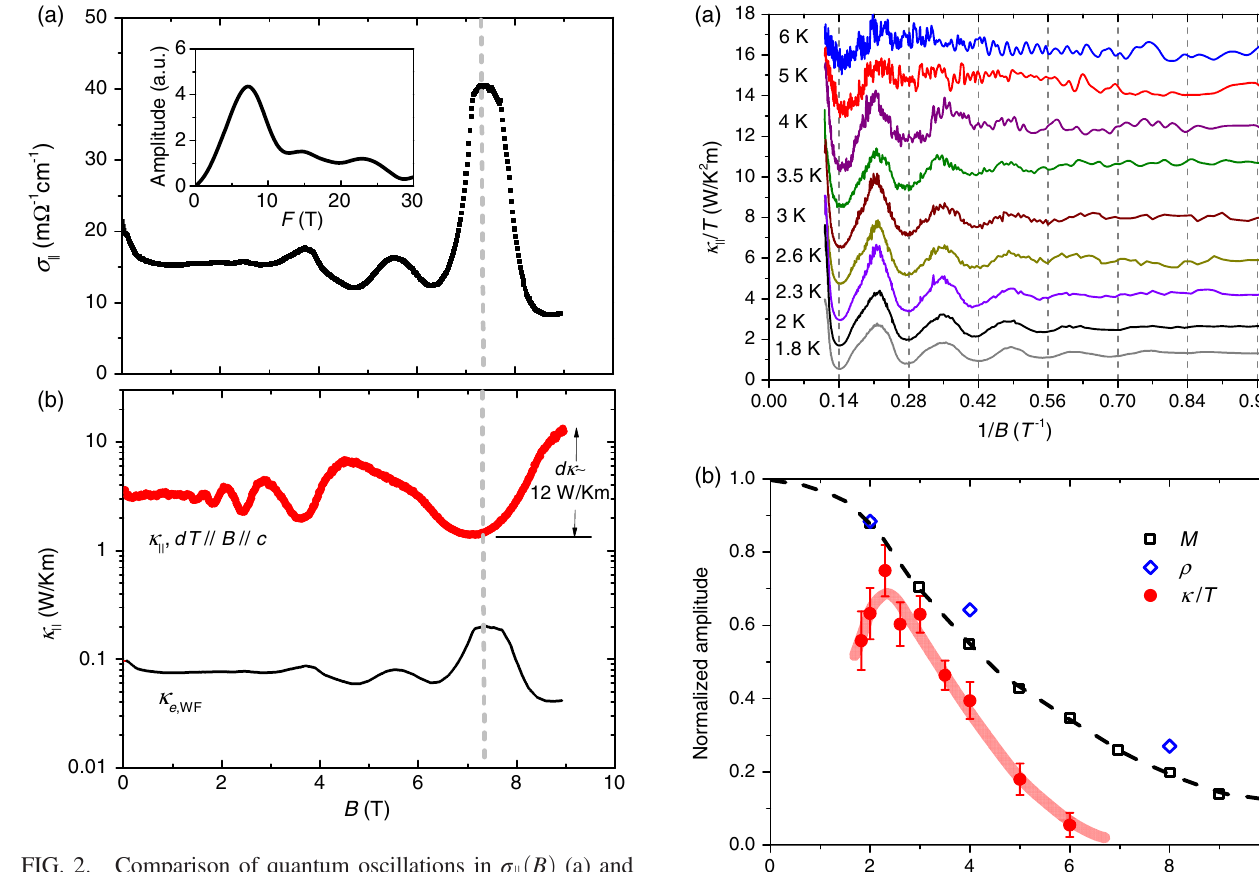
FIG. 2. Comparison of quantum oscillations in σ k ð B Þ (a) and κ ð B Þ (b) measured at 2 K for sample TAc. In a parallel field k configuration, σ k ð B Þ ¼ 1 = ρ k ð B Þ due to the absence of Hall FIG. 3. Evolution of the κ k ð B Þ MQOs as a function of the conductivity. The SdH oscillations in σ k ð B Þ reveal three charac- temperature. (a) Isothermal κ k =T curves as a function of B − 1 teristic oscillation frequencies (see FFT analysis shown in the measured at selected temperatures between T ¼ 1 . 8 and 6 K. A inset), in full agreement with literature data [19,21,22]. The characteristic frequency F ≈ 7 T can be readily observed from MQOs of κ k ð B Þ (b) measured in the parallel field configuration the T -independent oscillation period of approximately 0 . 14 T − 1 have one dominating frequency of F ≈ 7 T. Also shown in (b) is ð B Þ from σ ð B Þ using the WF law. The for all the curves. The corresponding FFT analysis is shown in the calculated κ k e; WF ð B Þ is 2 orders of magnitude smaller Fig. S7. For the sake of clarity, the κ k =T curves are shifted oscillation amplitude of κ e; WF upward by 7 (6 K), 6 (5 K), 5 (4 K), 5.5 (3.5 K), 4.5 (3 K), 3.5 than that of the measured ones [red points in (b)]. Note the (2.6 K), 2 (2.3 K), and 1 (2 K) units of W = K 2 m, respectively. logarithmic vertical axis in (b). The dashed line marks the (b) Temperature dependence of the normalized FFT amplitude of position of the last extremum, where the measured κ k ð B Þ exhibits ð B Þ assume a the characteristic MQOs with F ≈ 7 T, compared to the ones a minimum, whereas σ k ð B Þ and the calculated κ e; WF observed in magnetization (extracted from Ref. [22]) and maximum, with opposite phases (phase difference π ). electrical conductivity [cf. Fig. ð B Þ . The largest change in the last MQO period of κ ð B Þ σ k k [Fig. 2(b)] amounts to d κ ¼ 12 W = K m, i.e., 3.4 times the value of κ k ð B ¼ 0 Þ . The MQOs with F ≈ 7 T are practi- cally the only visible oscillating component in κ k ð B Þ ; cf. κ k ð B Þ =T vs B − 1 shown in Fig. 3(a) and the correspond- ing FFT analysis in Fig. S7 [24], in striking contrast to σ ð B Þ [Fig. 2(a)] and S ð B Þ (Fig. S3 [24]). The excellent k k agreement of this frequency with that of the Weyl pocket probed by other techniques [19,21,22] clearly indicates that the MQOs observed in κ k ð B Þ are a consequence of the Landau-quantized electronic density of states (DOS) of the